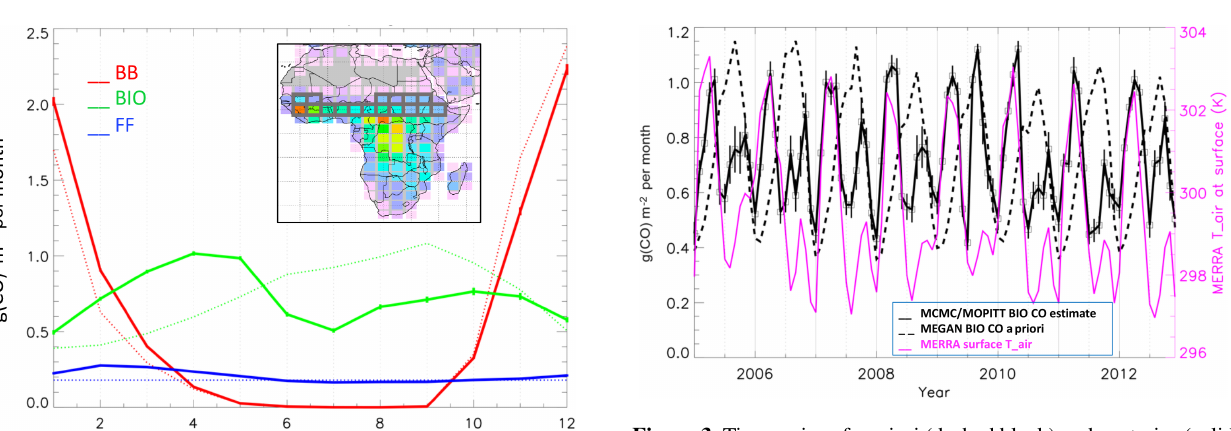
Figure 3. Time series of a priori (dashed black) and posterior (solid black) CO fluxes with monthly mean 1 σ errors and MERRA surface air temperature (magenta) for the North African savannas region (see inset map in Fig.